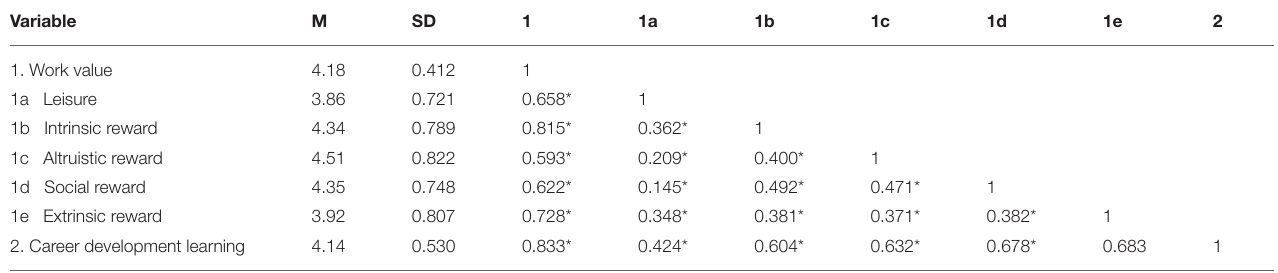
TABLE 5 | Mean, SD, and correlation matrix.